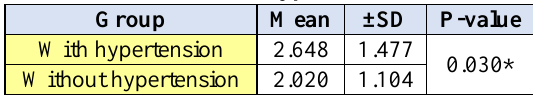
Table 4: Matrix metalloproteinase- 8